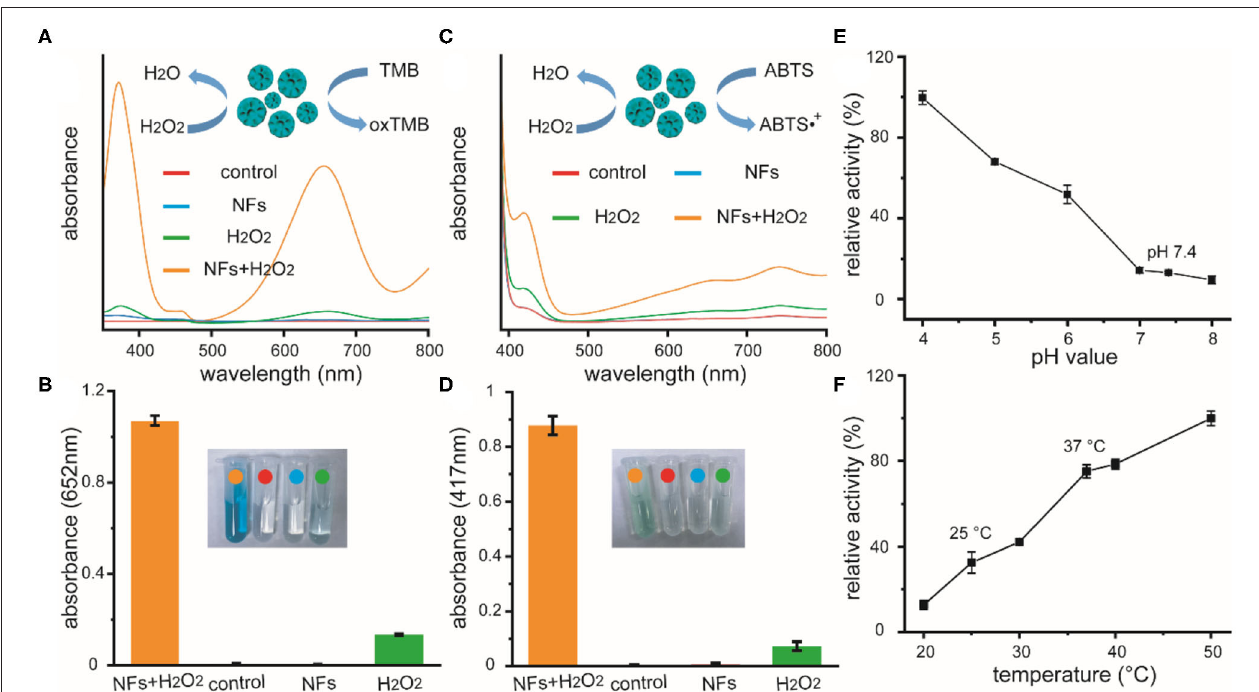
FIGURE 2 | Absorption curves of TMB solutions (A) and ABTS solutions (C) upon different treatments, as well as relative quantitive absorbance changes at 652 or 417nm as a result of the catalyzed oxidation of TMB (B) or ABTS (D) , respectively. Inset of (A,C) : schematic illustration for the peroxidase-like catalytic activity of nanoflowers in the presence of TMB or ABTS. Inset of (B,D) : photographic images of corresponding solutions after different treatments. Effects of pH value (E) and temperature (F) on the catalytic activities of